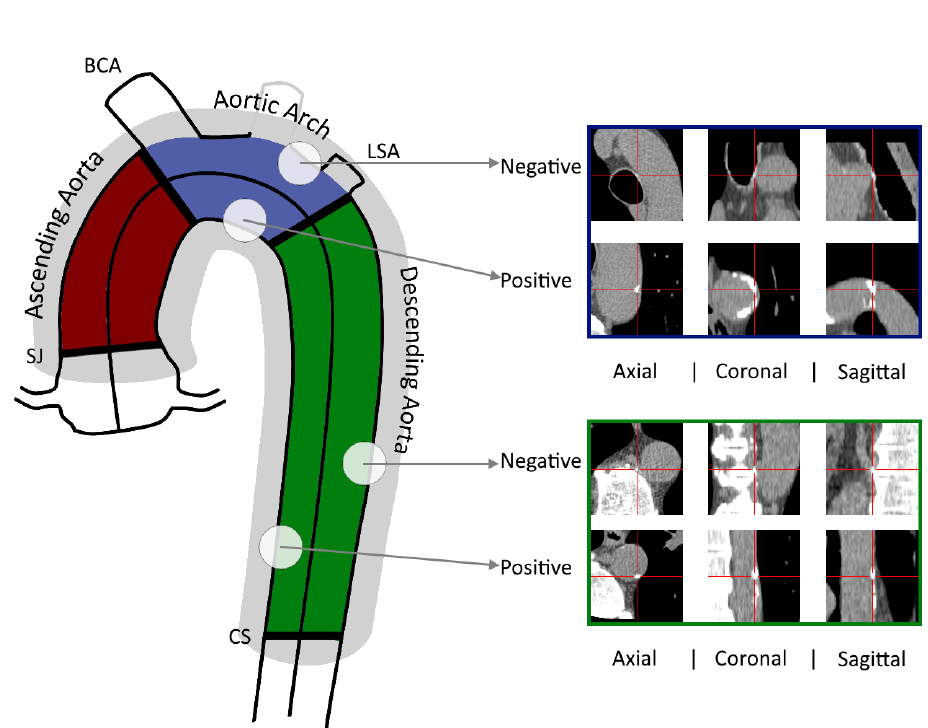
Figure 1. The thoracic aorta was segmented and separated into its ascending, arch and descending portions. Axial, sagittal and coronal images (128 × 128 px) centered at each candidate lesion were reconstructed. Examples of positive and negative calcifications in the regions of the aortic arch and the descending aorta are shown. BCA: brachiocephalic artery, CS: coronary sinus, LSA: left subclavian artery, SJ: sinotubular